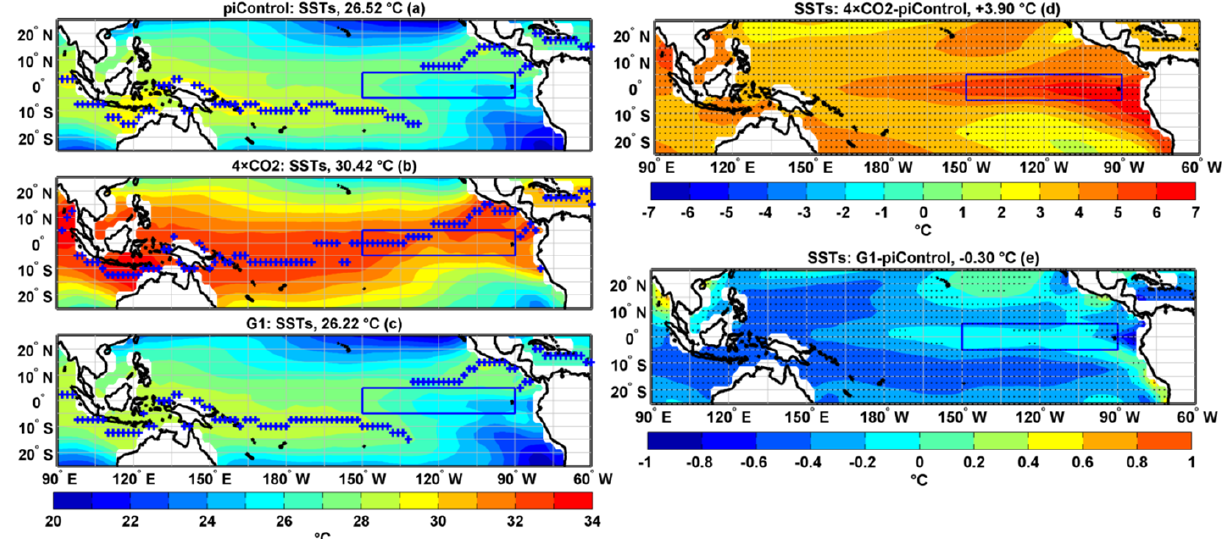
Figure 1. Tropical Pacific SST mean DJF climatology: (a) piControl, (b) 4 × CO 2 , (c) G1, (d) 4 × CO 2 − piControl difference, and (e) G1 − piControl difference. The blue plus sign in (a) – (c) indicates latitudes with maximum SSTs. Stipples indicate grid points where the difference is statistically significant at 99%cl using a non-parametric Wilcoxon rank-sum test. The box in the eastern Pacific identifies the Niño3 region. The numbers in (a) – (c) represent a mean temperature in the corresponding simulation, and numbers in (d) – (e) represent an area-averaged difference in piControl with 4 × CO 2 and G1, respectively, in the tropical Pacific region (25 ◦ N–25 ◦ S, 90 ◦ E–60 ◦